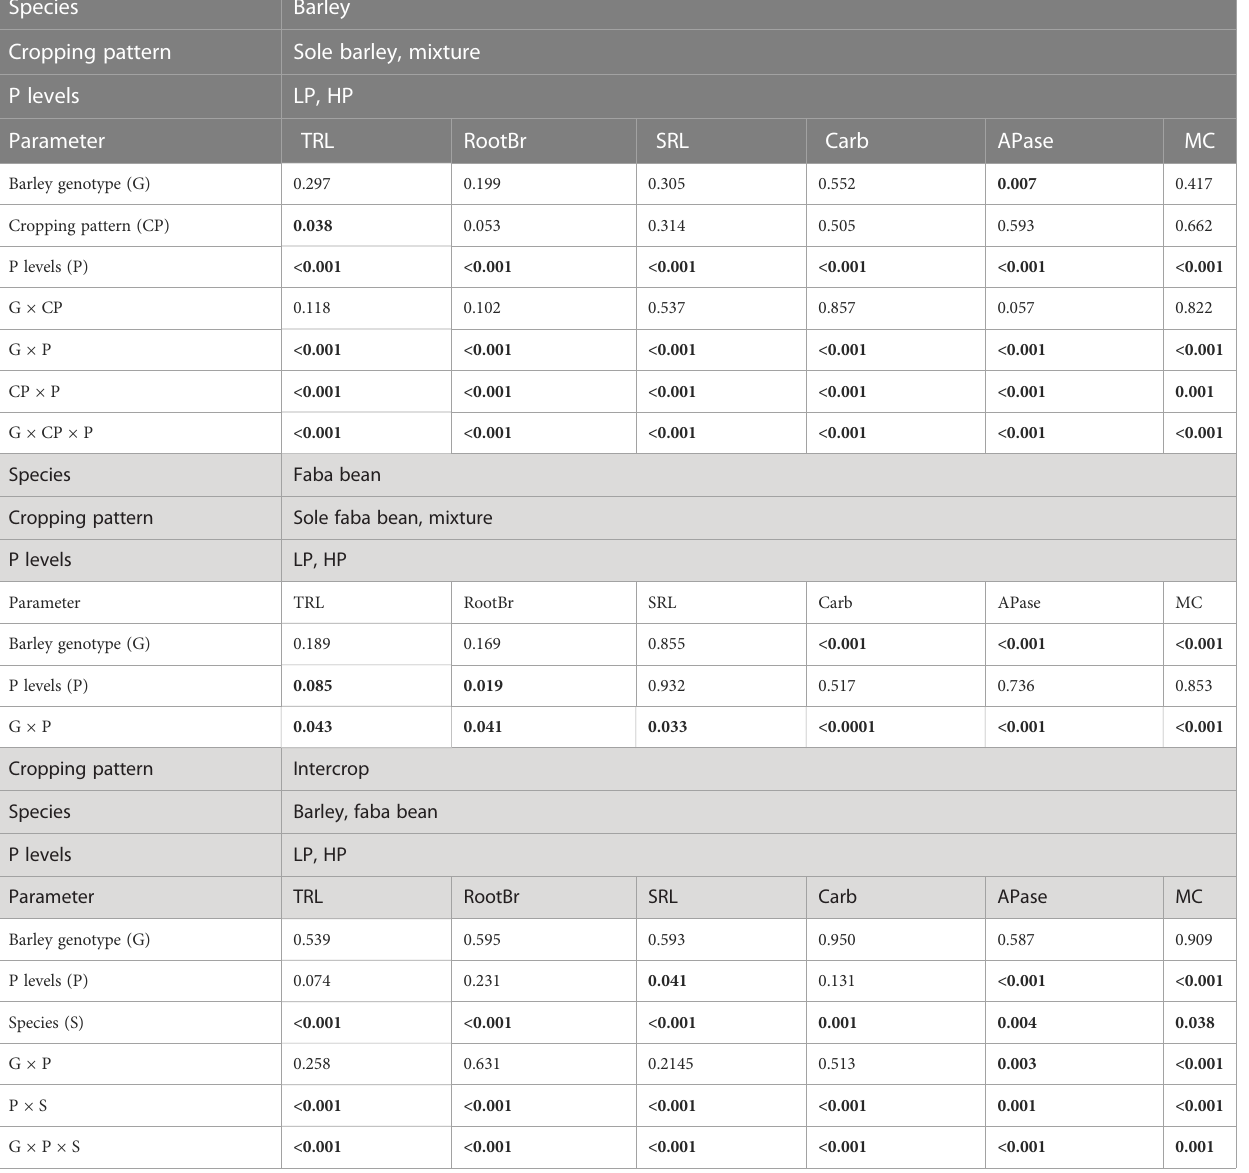
TABLE 2 The p -values of the linear model analyzing six root functional traits. Species Barley Cropping